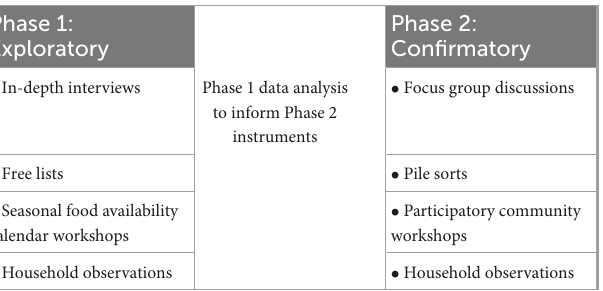
TABLE 2 Participant types by level of the Social Ecological Model